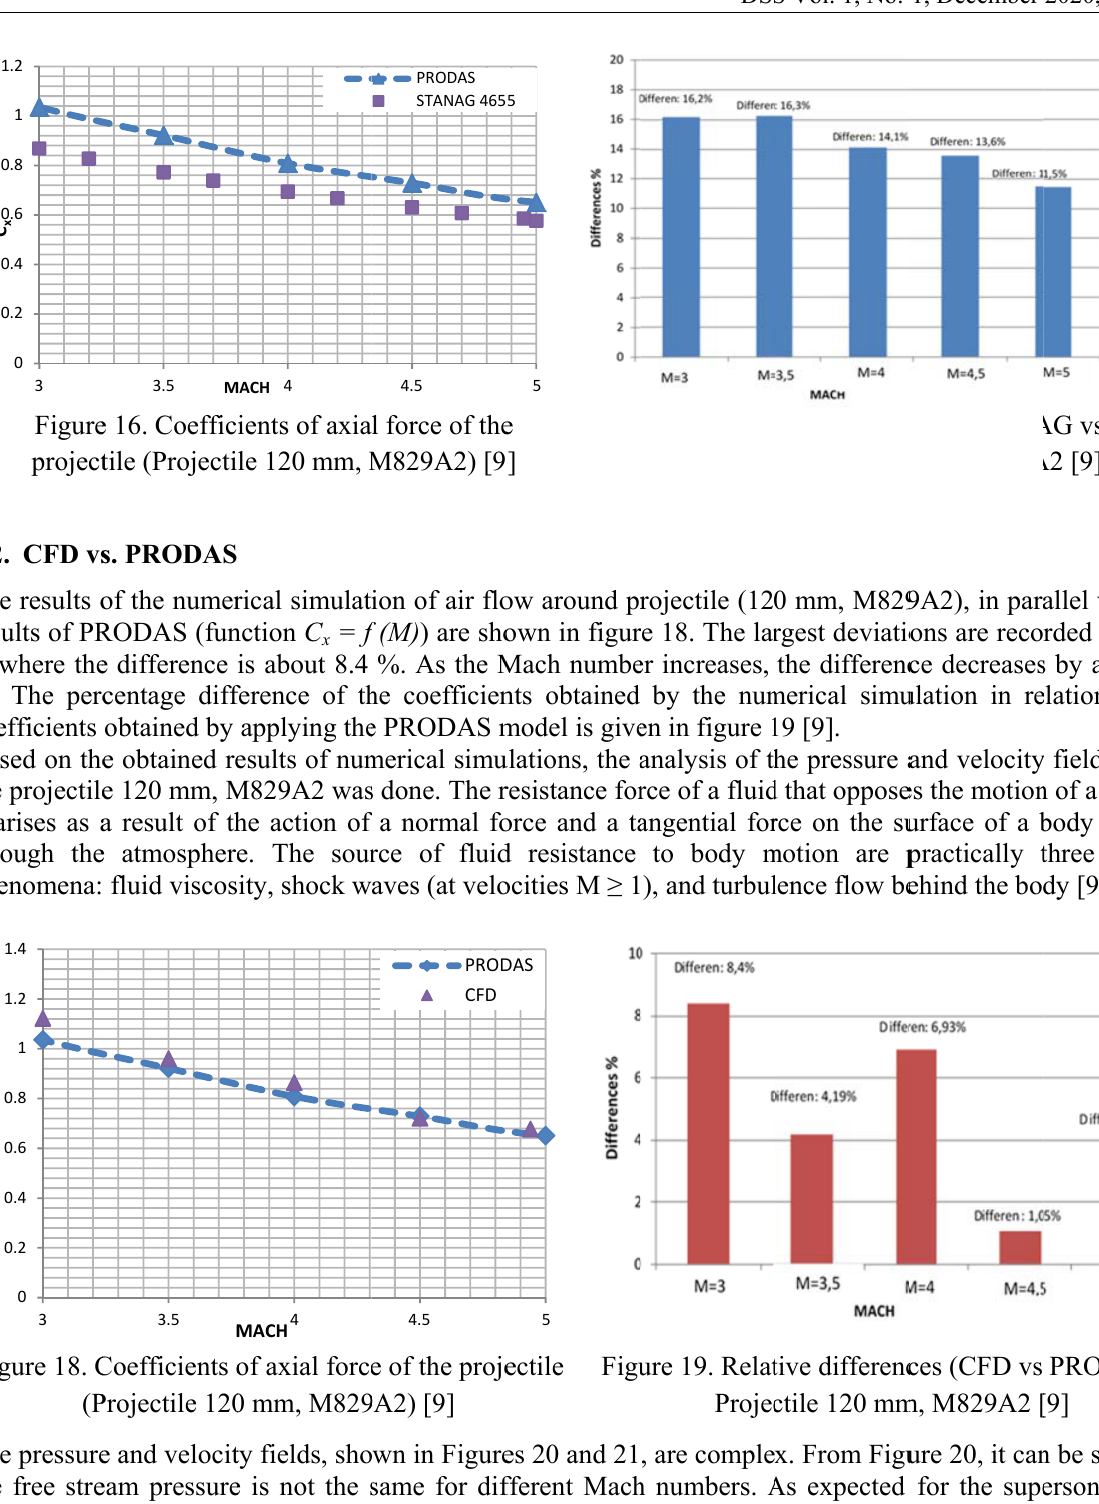
x. From Figu As expected acteristic und of the